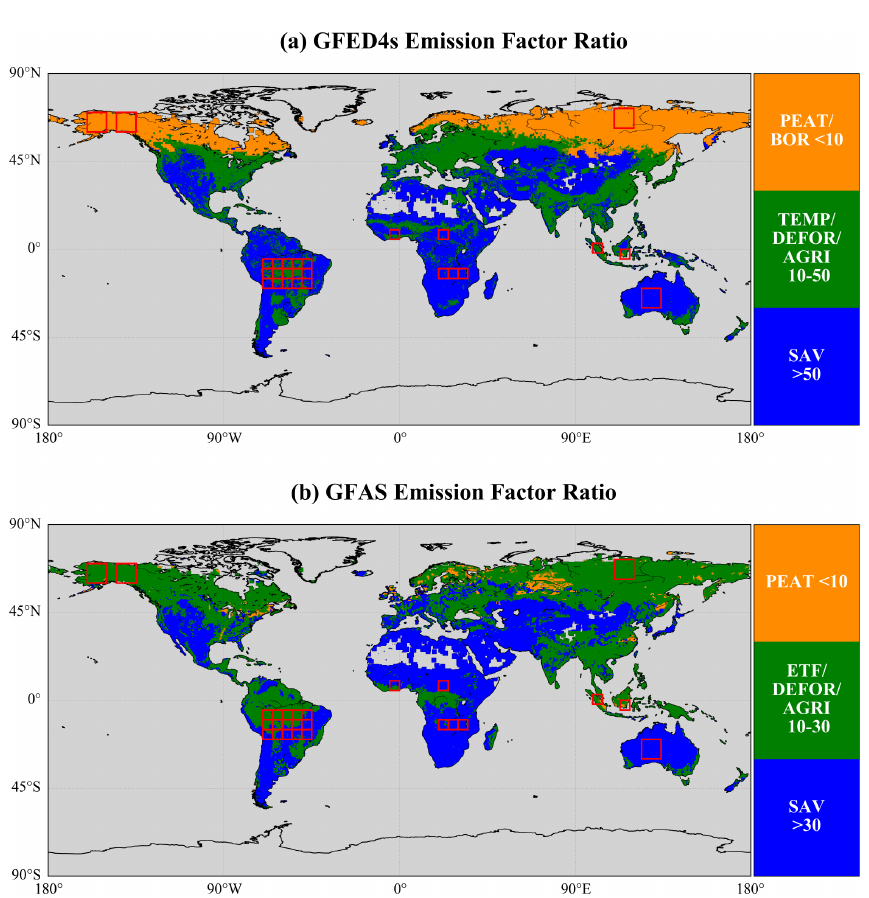
Figure 1. Emission factor ratio between NO x and CO (EFR) for GFED4s (a) and GFAS (b) . In panel (a) the range of EFR values is subdivided into three aggregated fire-type categories: (1) peat and boreal fires (PEAT/BOR: < 10), (2) temperate forest, deforestation and agricultural fires (TEMP/DEFOR/AGRI: between 10 and 50) and (3) savanna fires (SAV: > 50). In panel (b) the range of EFR values subdivided along a different classification (see Sect. 2.1): (1) peat fires (PEAT: < 10), (2) extratropical forest, tropical deforestation and agricultural fires (ETF/DEFOR/AGRI: between 10 and 30), and (3) savanna fires (SAV: > 30). Regions of interest are highlighted by the red